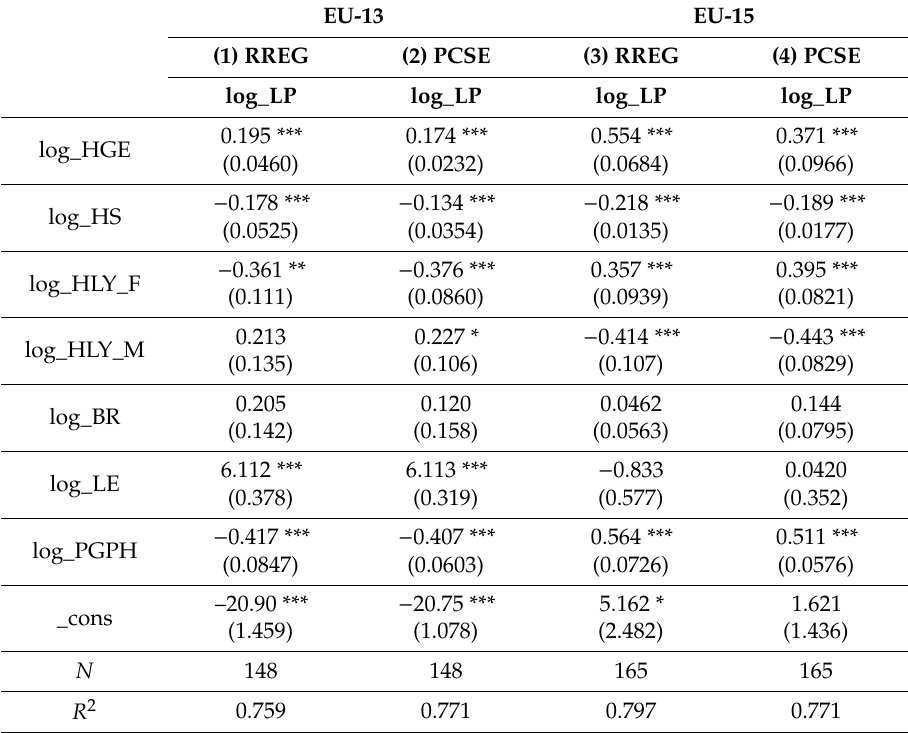
Table A8. Results of macroeconometric models deployed for H 4 , EU-13 and EU-15,